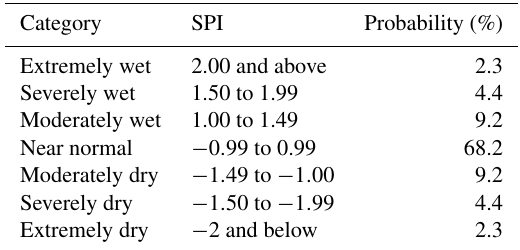
Table 3. Drought classification based on SPI according to Mckee et al. (1993).